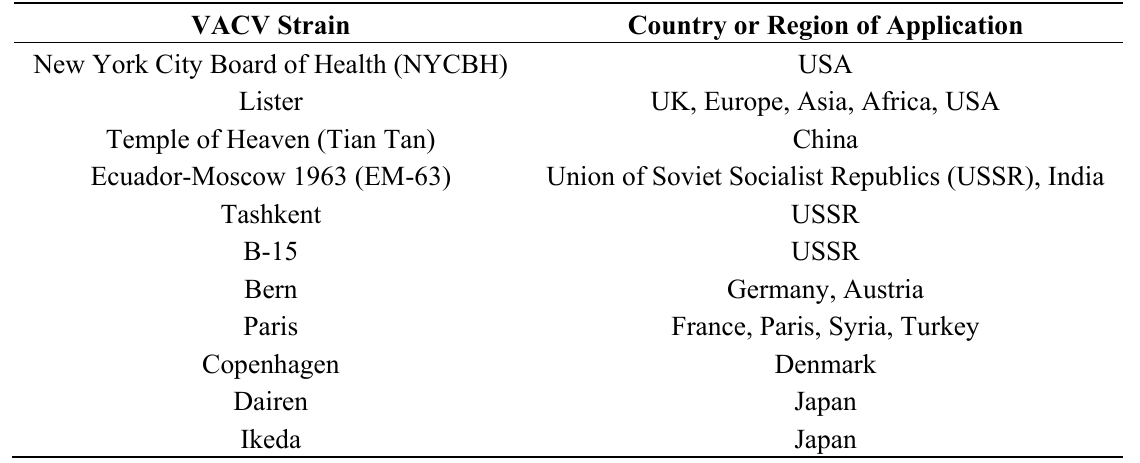
Table 1. List of the different VACV strains used in the global smallpox eradication